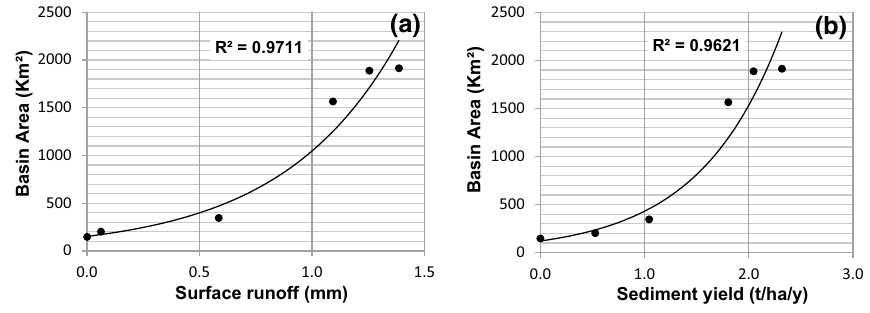
Fig. 8 Relationship between basin area increases a surface runoff increase b sediment yield